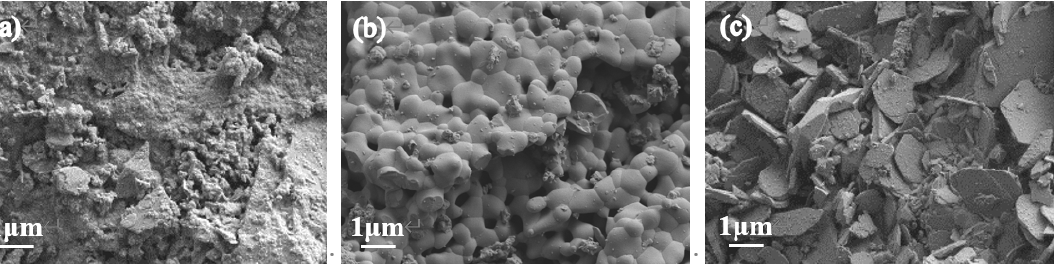
Figure 10. SEM images of different additive ratios and roasting processes. ( a ) Micromorphology of the high-nitrogen aluminum dross; ( b ) with sodium carbonate added; ( c ) with cryolite added.